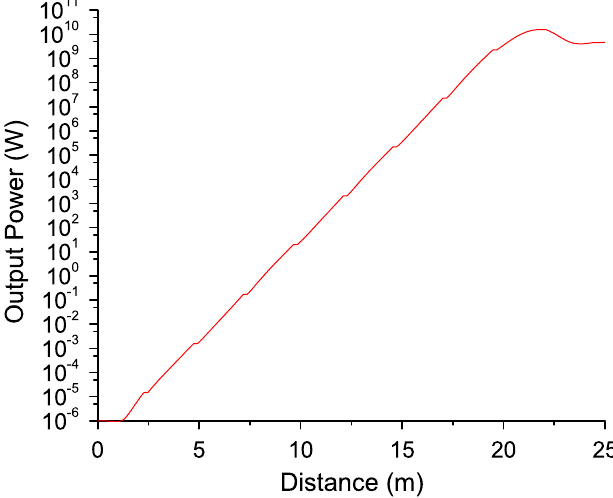
FIG. 10. (Color) GENESIS simulation of the LCLS 20 pC beam at derated energy of 4.5 GeV, compliance with Pellegrini criterion reestablished.